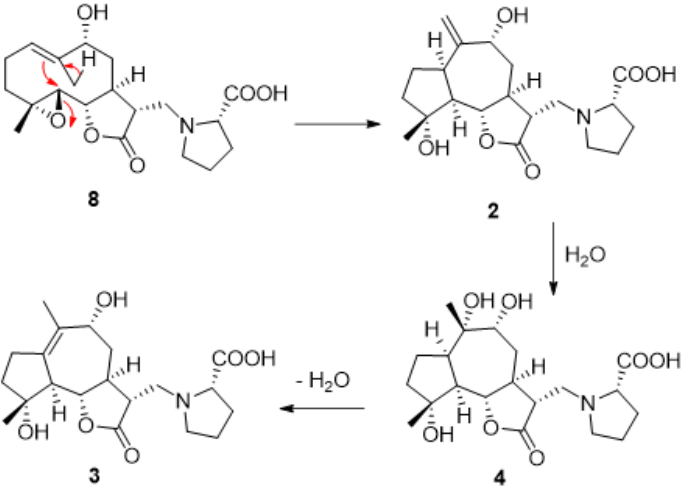
Figure 3. Biosynthetic relationship among some of the isolated sesquiterpenoids. Figure 3 . Biosynthetic relationship among some of the isolated sesquiterpenoids.